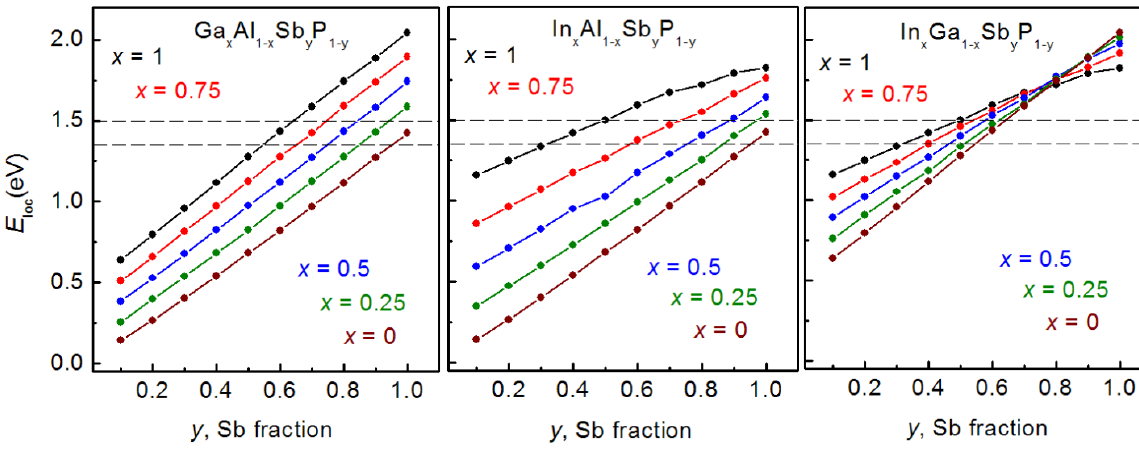
Figure 11. E loc ( y ) dependences for different contents of group III elements, as calculated for Ga x- dashed lines indicate the energy range of E loc = 1.35–1.5 eV required for 10 years of hole storage [12,13,32,34].